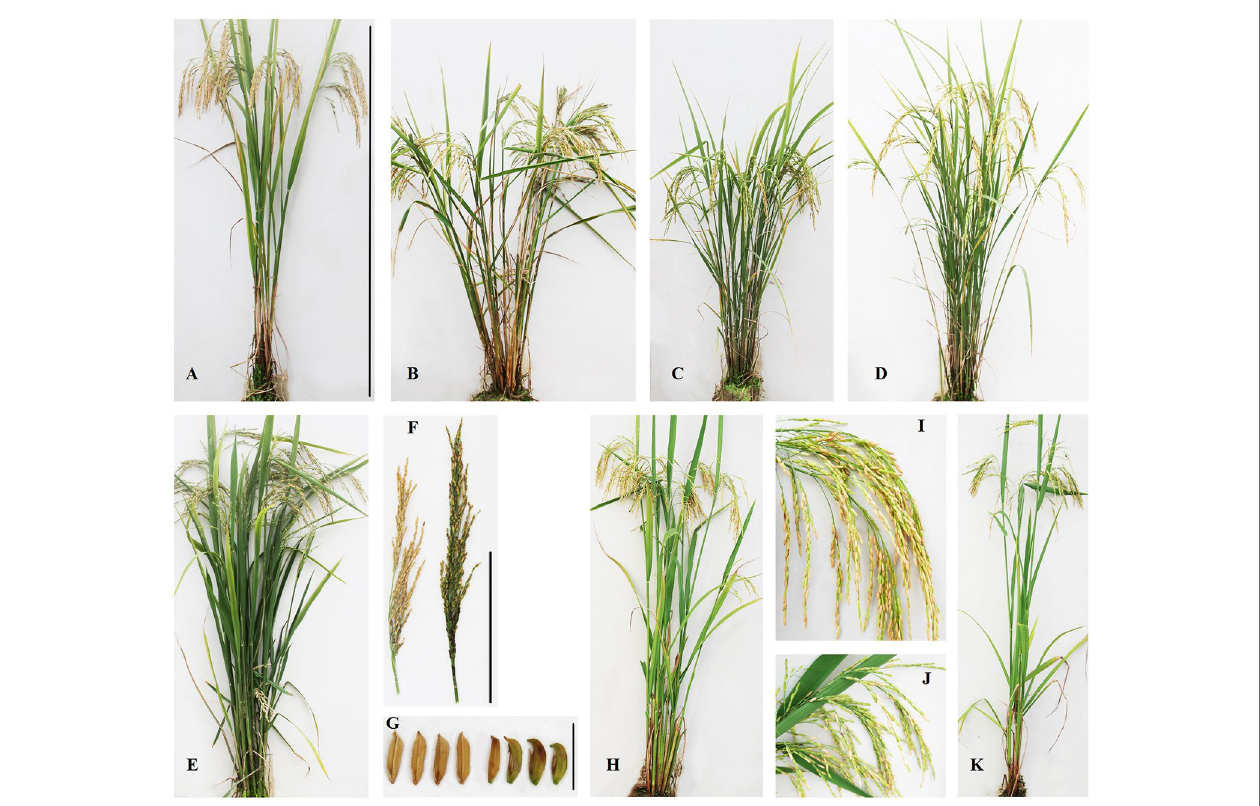
FIGURe 1 | Phenotypes of the mutant lines induced by CIBs and GRs. (a) : R173, Wild type (Bar: 100cm); (B) : H409 (semi-dwarf); (C) : H410 (semi-dwarf); (D) : H411 (semi-dwarf); (e) : H404 (abnormal floret); (F) : The panicles of H404 (right) and WT (left) (Bar: 20cm); (G) : The spikelet of H404 (right) and WT (left) (Bar: 10cm); (h) : H634 (lower seed set); (I) : The panicle of H634; (J) : The panicle of H635; (K) : H635 (lower seed set).